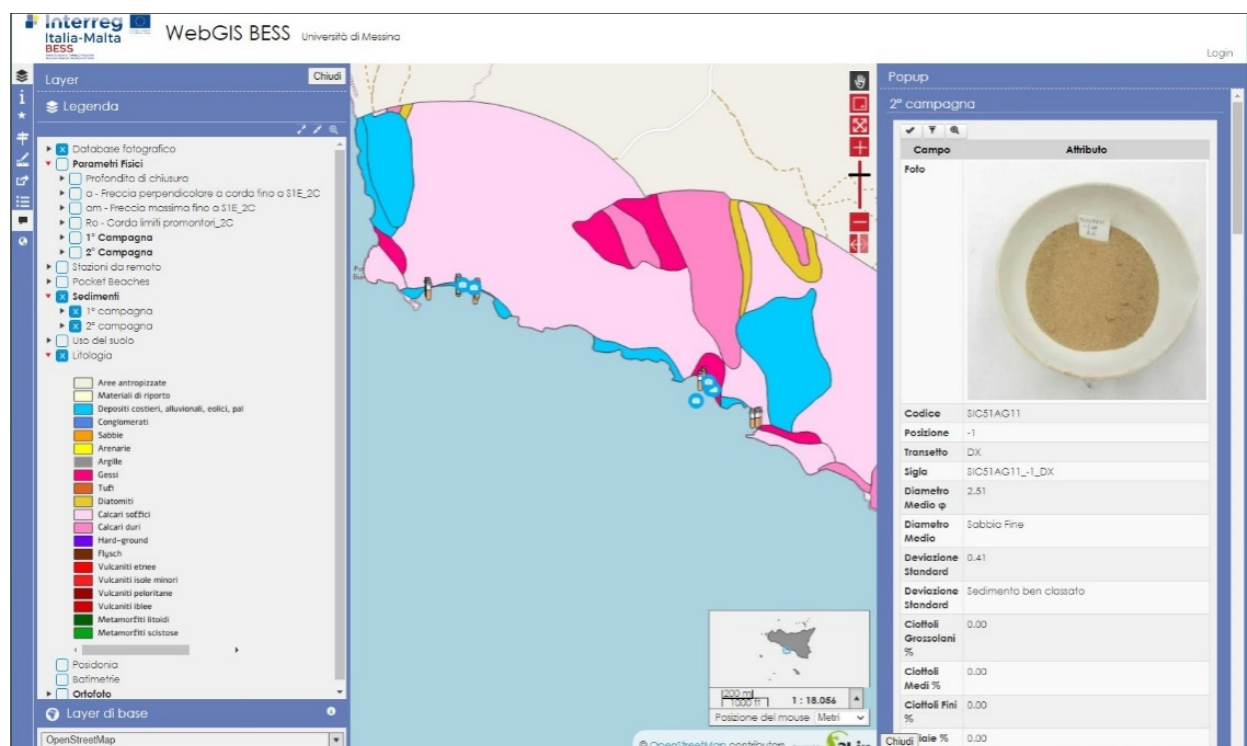
Figure 8. WebGIS platform that shows the overlap between samples, lithology, and photo collection of the pocket beach of Palma di Montechiaro (Agrigento). On the right, the popup between the last two obtained by clicking on the photo collection.